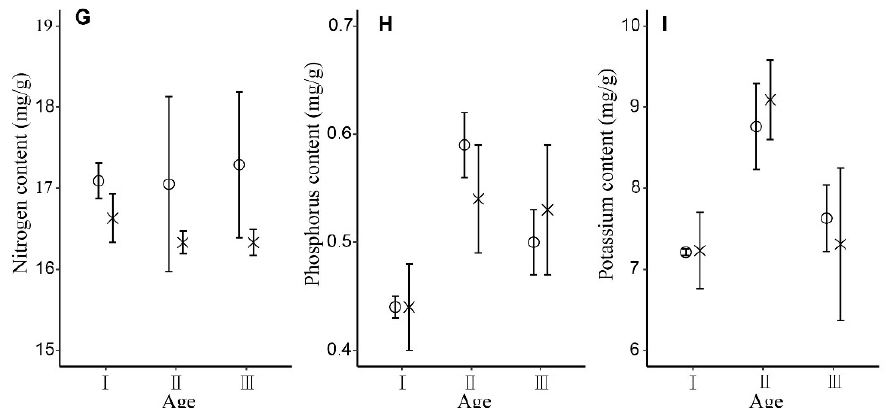
Figure 2. Nutrient content of Moso bamboo culm ( A – C ), branch ( D – F ), and leaf ( G – I ) at different ages at the two study sites SC (o) and CK (x). Error bars represent standard deviation (n = 3). Asterisks indicate differences between study sites at different levels of significance: p ≤ 0.001 = ***; p ≤ 0.01 = **; p ≤ 0.05 = *. I “du” bamboo refers to a 1-year-old bamboo, II “du” refers to 2–3-year-old bamboo, and III “du” refers to 4–5-year-old bamboo.